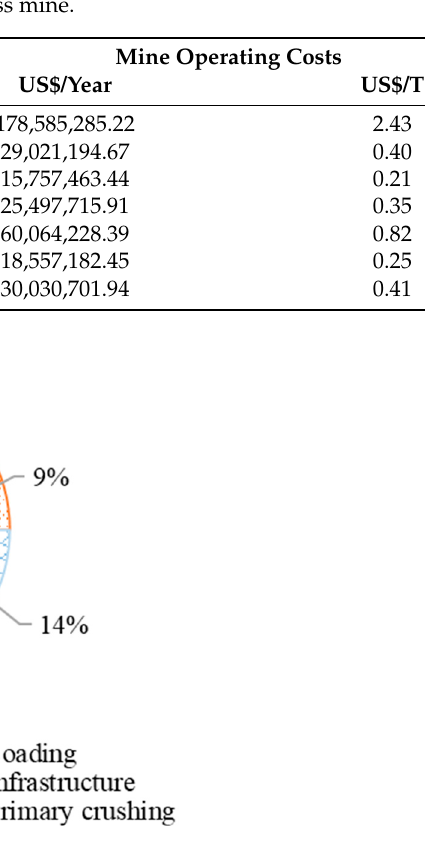
Figure 3. Mine operating cost distribution of the truckless mine.